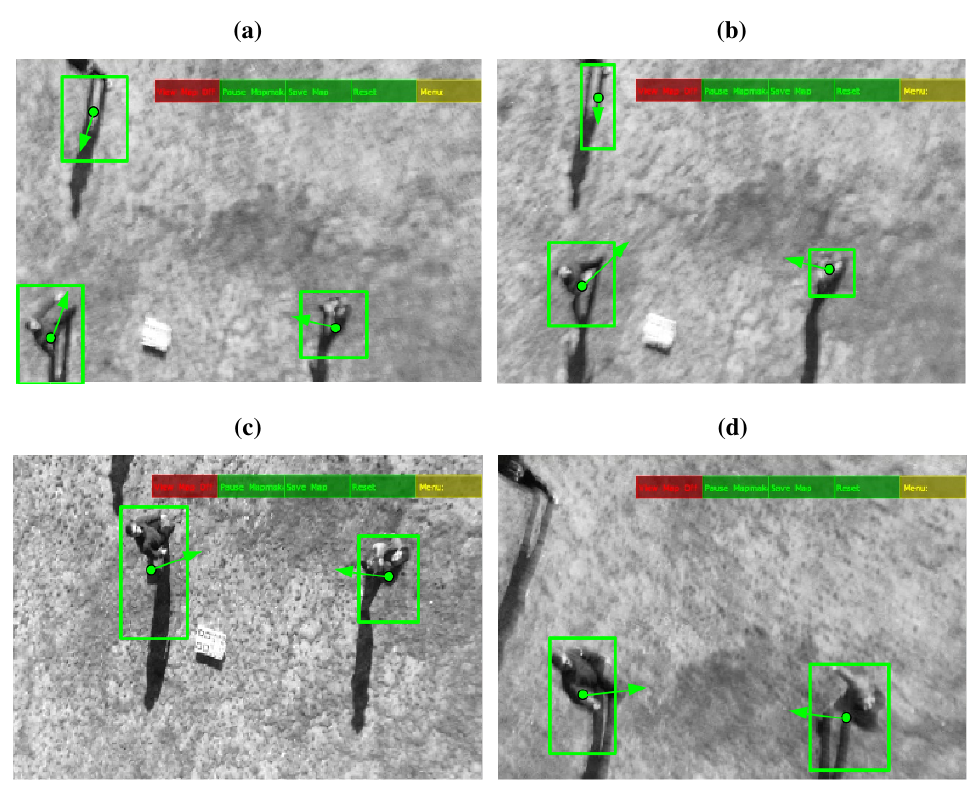
Figure 11. Example of detection and tracking of multiple dynamic objects. In (a), (b), (c) and (d) the dynamic objects’ position and direction are highlighted. One of the objects stops moving during this test